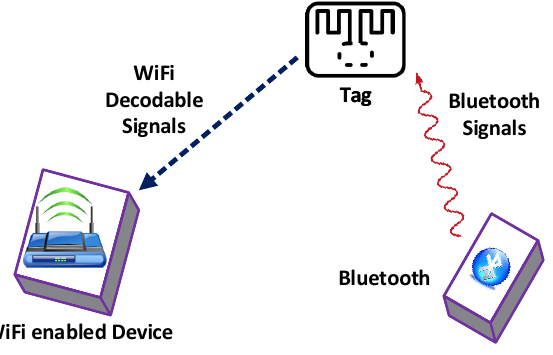
Figure 32. Technology conversion in